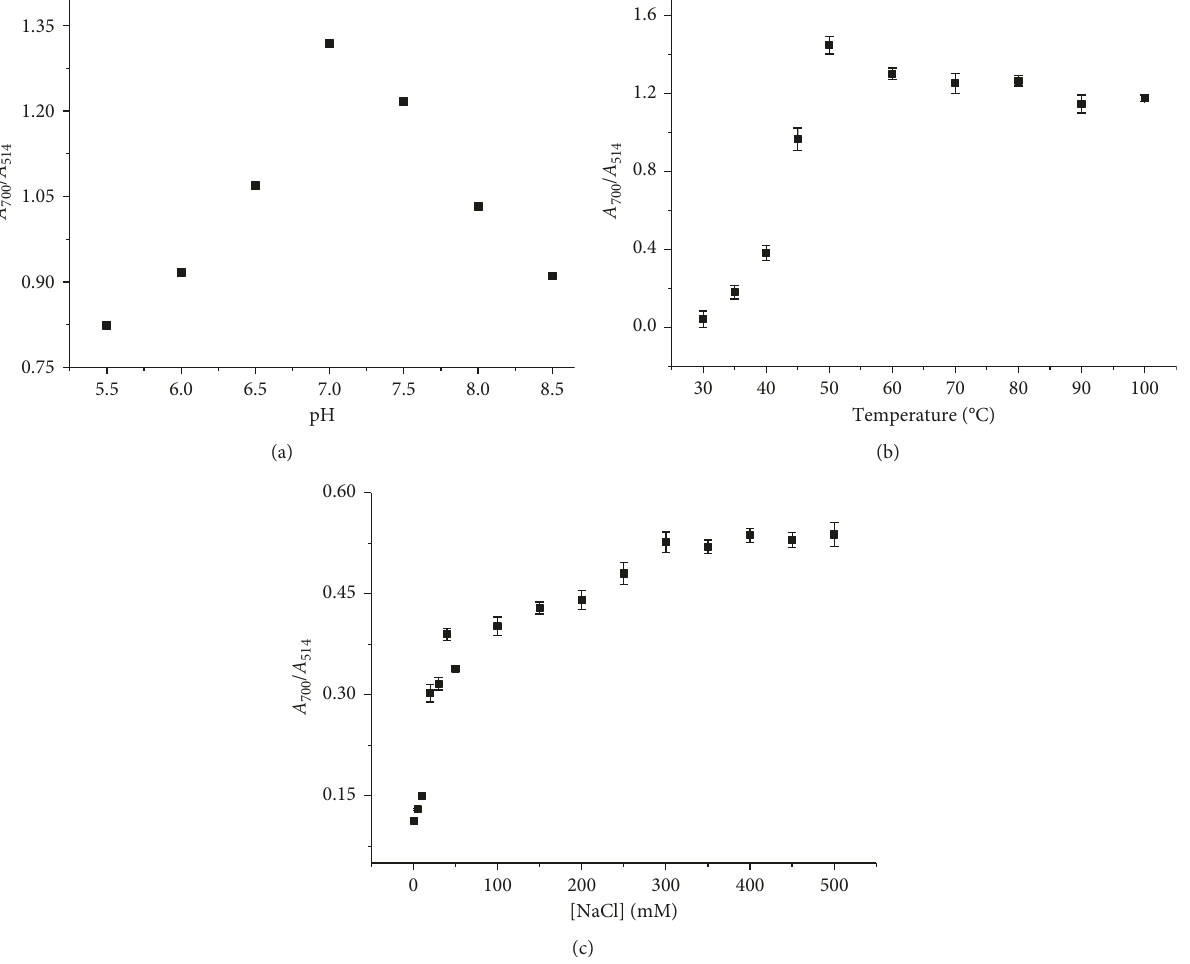
Figure 5: Absorption ratios ( A 2+ -PEI-AuNPs as a function of (a) pH, (b) temperature, and (c) concentration of 700 / A 514 ) of Hg